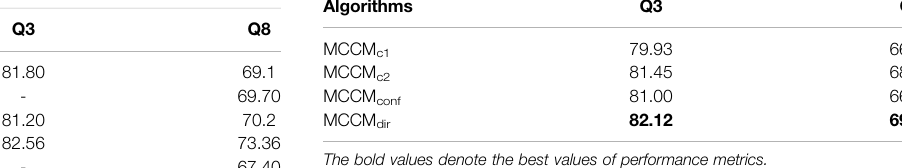
TABLE 1 | Q3 and Q8 accuracy of different algorithms on the public CB513 dataset. Algorithms